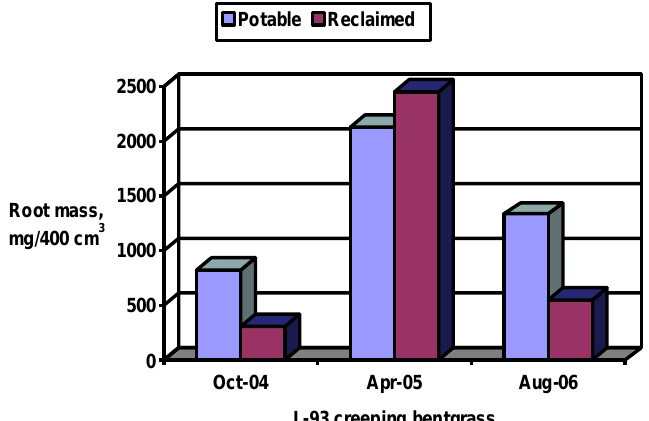
Figure 4. Effects of irrigation water source on root mass of bentgrass in 2004, 2005, and 2006. Root mass was higher (P < 0.05) with potable than reclaimed water in October 2004 and August 2006.